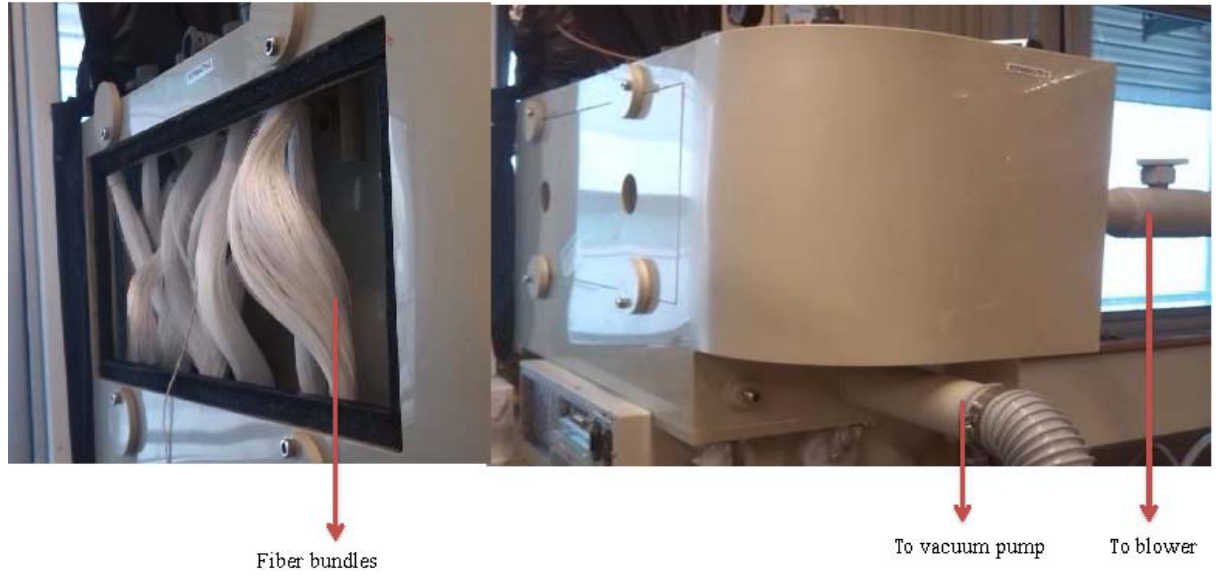
Figure 7. Home-made fiber bundles and the dehumidification pilot